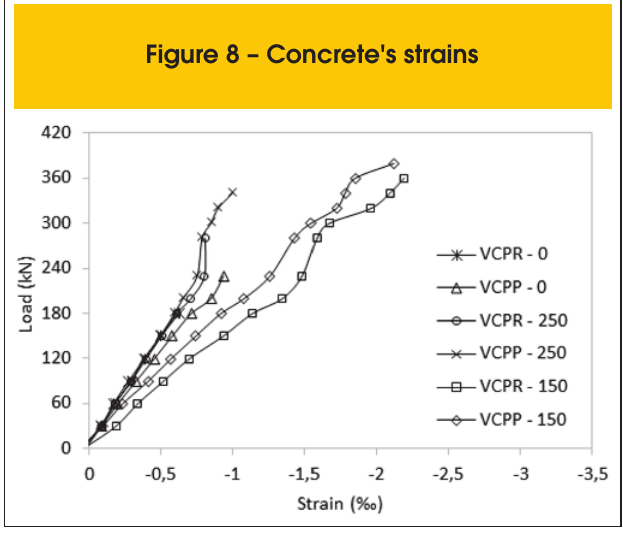
Figure 8 – Concrete's strains